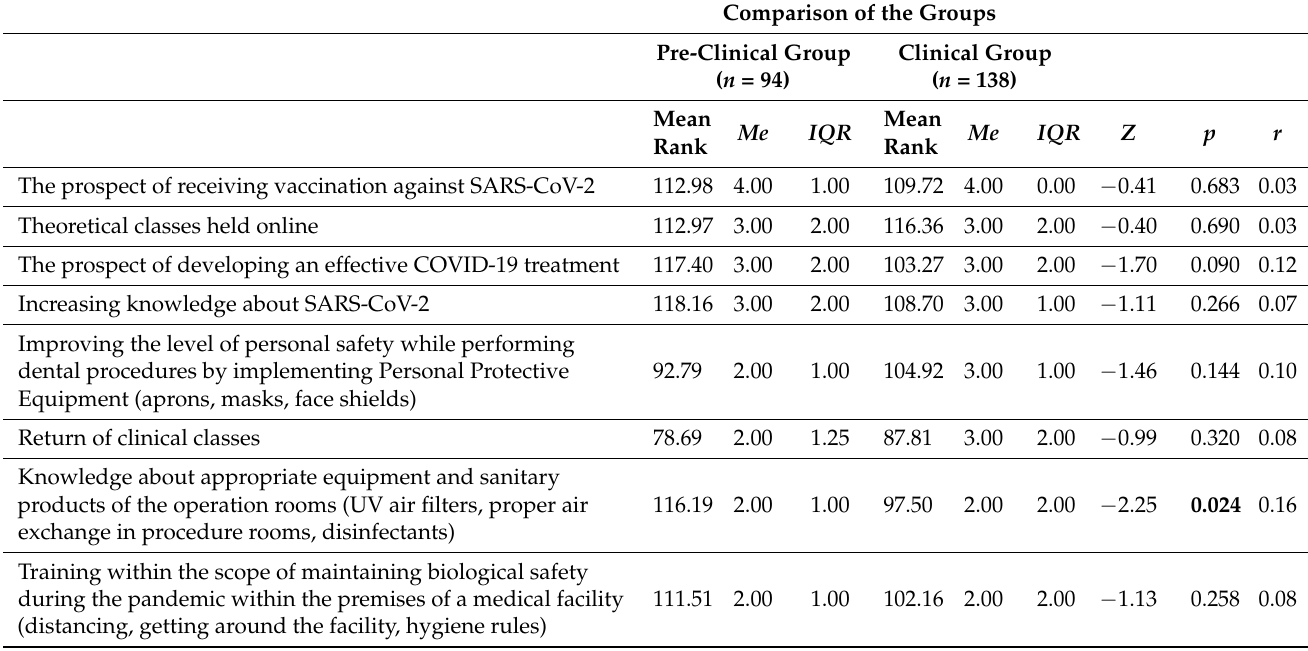
Table 4. U-Mann–Whitney test for comparison of implemented preventive activities on